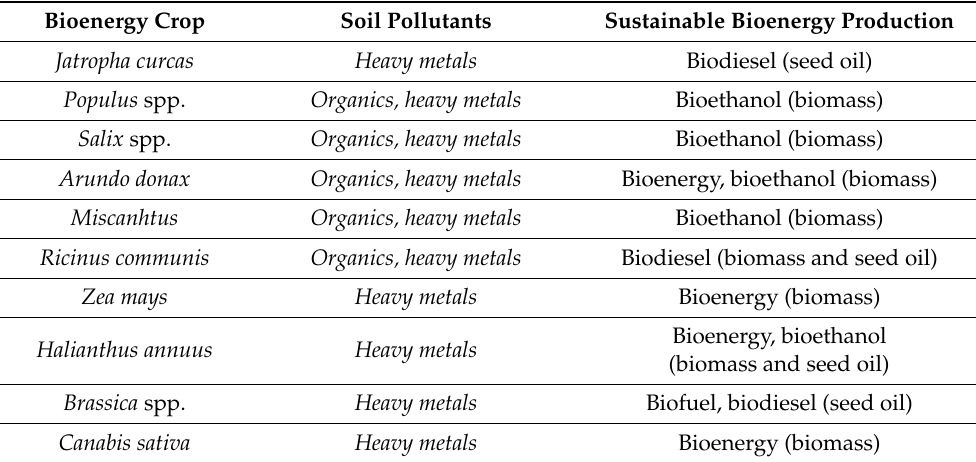
Table 5. List of energy crops used in phytoremediation with consideration of bioenergy